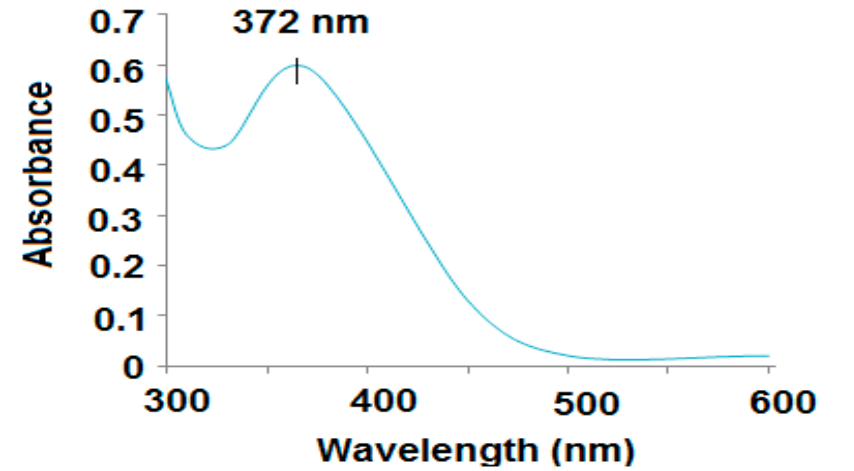
Figure 3. UV spectrum of zinc oxide nanoparticles, the absorption was measured at a wavelength of 200–600 nm.